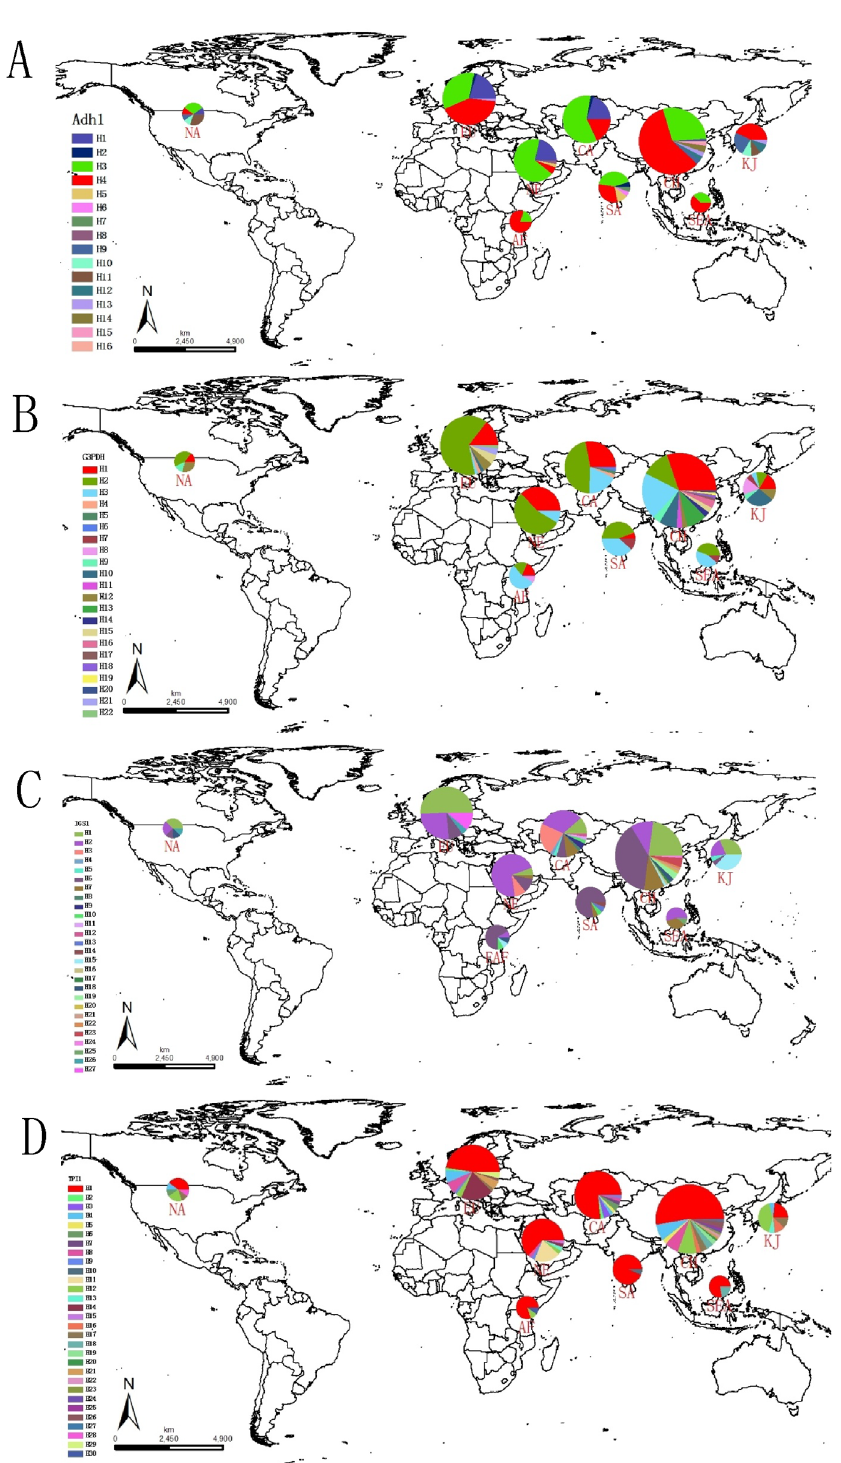
Fig 1. Geographic distribution of haplotypes of foxtail millet. The distribution of haplotypes for the (A) ADH1 , (B) G3PDH , (C) IGS1 , (D) TPI1 locus are shown. Each distributed regions are indicated by circles. Different colors delineate specific haplotypes. The size of the circles in the figure corresponds to numbers of accessions in a given region.